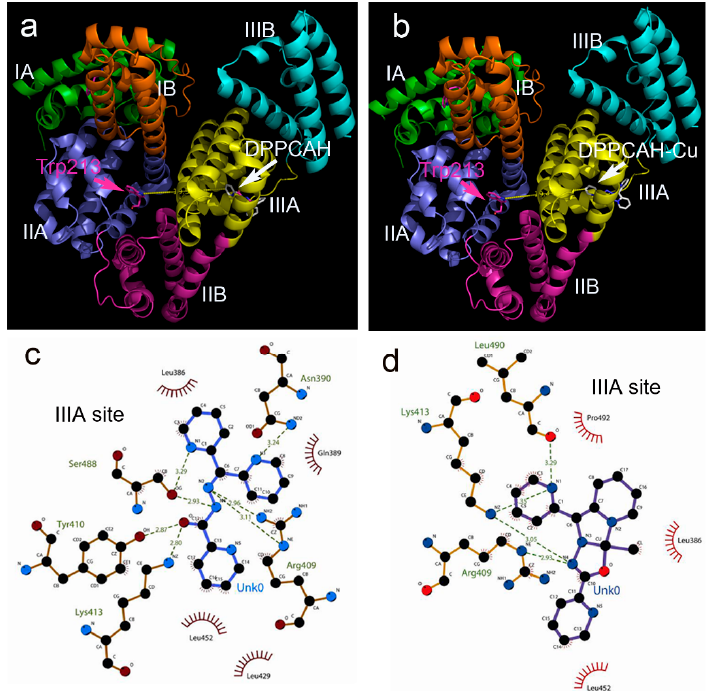
Figure 9. The interaction modes between of BSA with DPPCAH and DPPCAH-Cu: ( a ) DPPCAH was located in the IIIA site; ( b ) DPPCAH-Cu was located in the IIIA site; ( c ) interaction of DPPCAH with environment residues (in the figure Unk0 = DPPCAH); ( d ) interaction of DPPCAH-Cu with environment residues (in the figure Unk0 = DPPCAH-Cu). Yellow line indicates the distance (Figure 9a,b) and dark green dash lines (Figure 9c,d) indicated hydrogen bonds. The eye-like curved dark red lines represented the hydrophobic residues in contact.